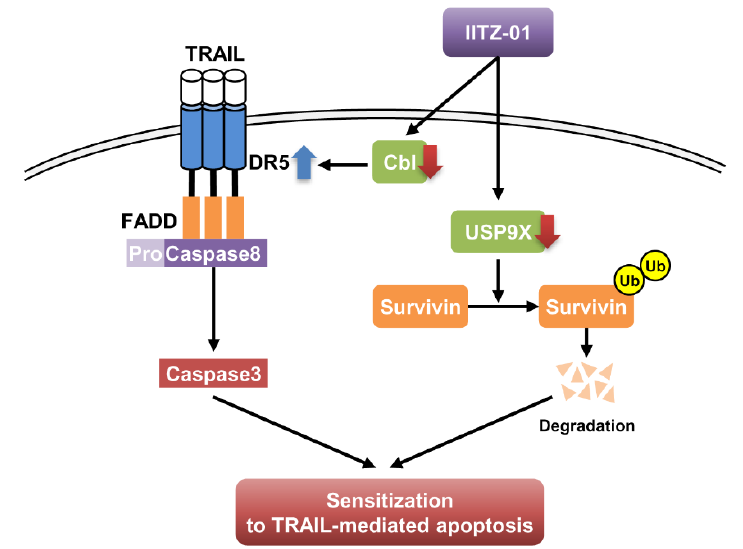
Figure 8. The diagram indicating the mechanism of IITZ-01-induced TRAIL sensitization.